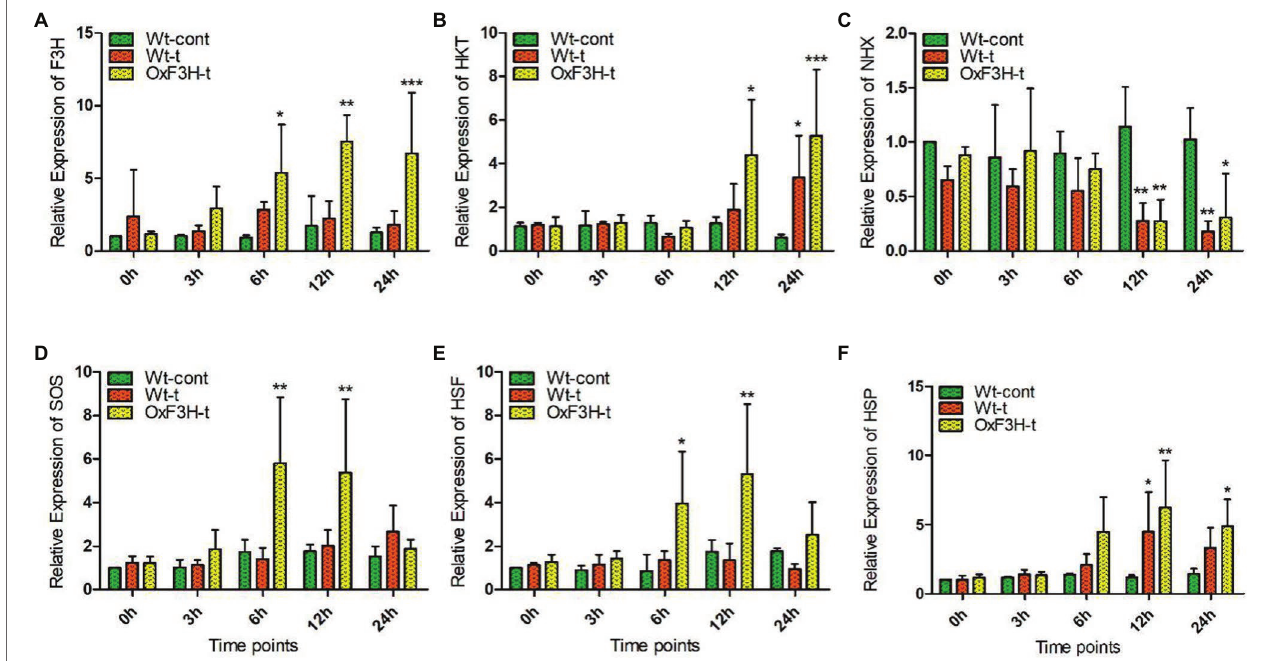
FIGURE 2 | Overexpression of F3H significantly regulates salt- and heat-related genes during combined salt and heat stress. (A–F) Relative expression of F3H , HKT , NHX , SOS , HSF , and HSP , respectively, in Wt-control, Wt-t, and OxF3H-t plants. The fold change of each gene was measured after 0-, 3-, 6-, 12-, and 24-h intervals of continuous stress exposure, with actin used as a reference gene. Graphs show mean ± standard deviation, and asterisks show significant differences (* p ≤ 0.05, ** p ≤ 0.01, and *** p ≤ 0.001) according to two-way ANOVA and Bonferroni post hoc